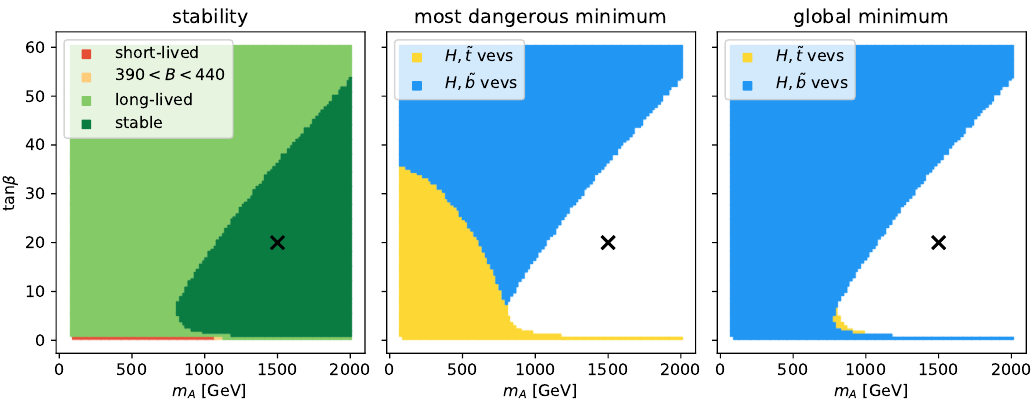
Figure 3 . Constraints from vacuum stability in the M 125 scenario de(cid:12)ned in [60]. The colour code h in the left panel indicates the lifetime of the EW vacuum, while the centre and right panels illustrate which (cid:12)elds have non-zero vevs at the most dangerous and the global minimum, respectively. The black (cid:2) marks the same point shown in (cid:12)gure